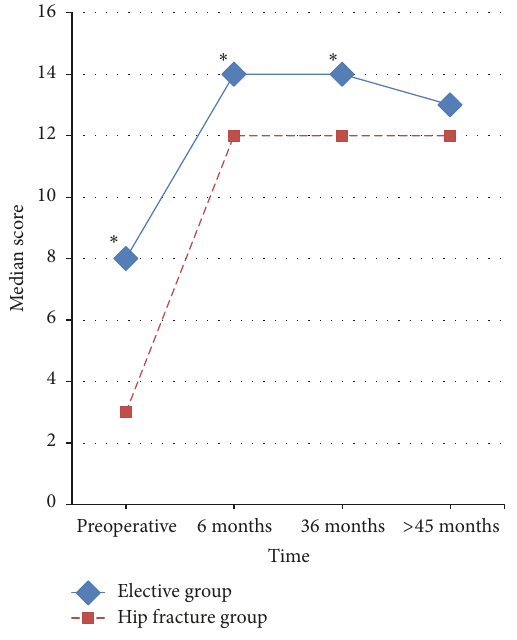
Figure 2: Line graph of pain scores by time in the elective and hip fracture group. Comparison of the progress of the medians of pain score during follow-up. The asterisk ( ∗ ) indicates the statistically significant difference between the compared